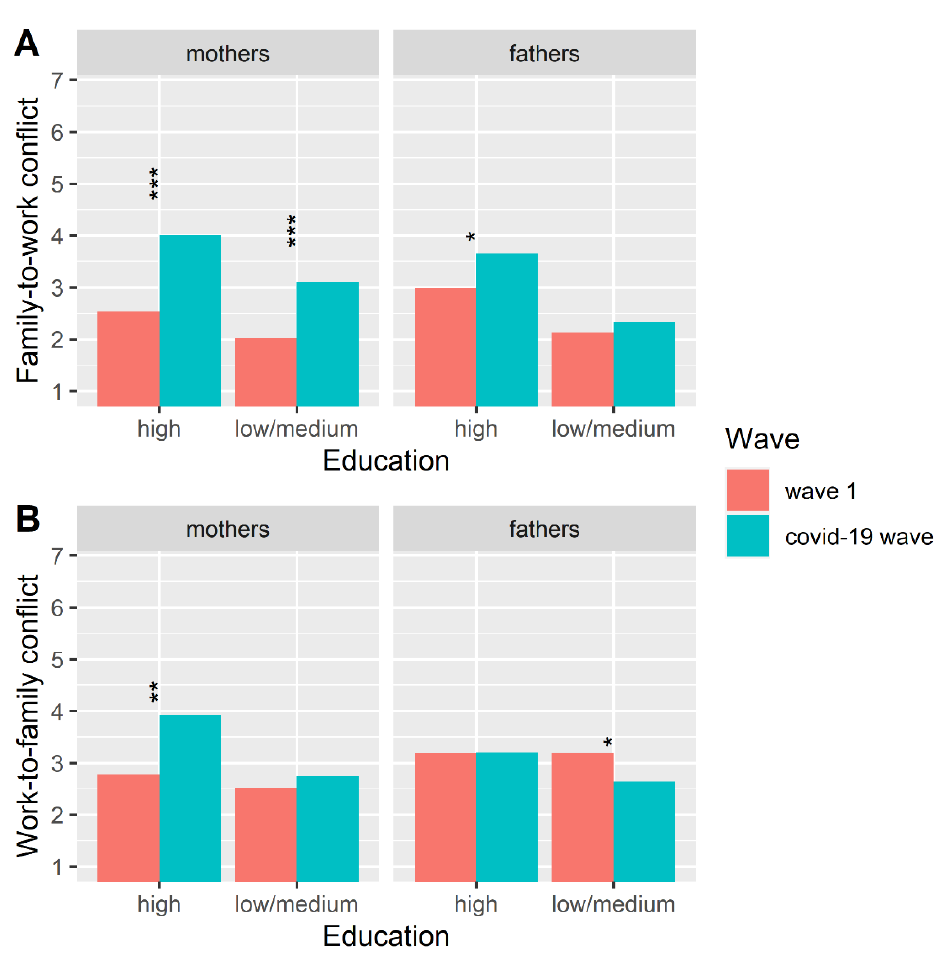
Figure 1 : F → W-conflict (A) and W → F-conflict (B) at the two different waves, for fathers and mothers of different educational levels. Significance of difference between waves based on paired t-tests are